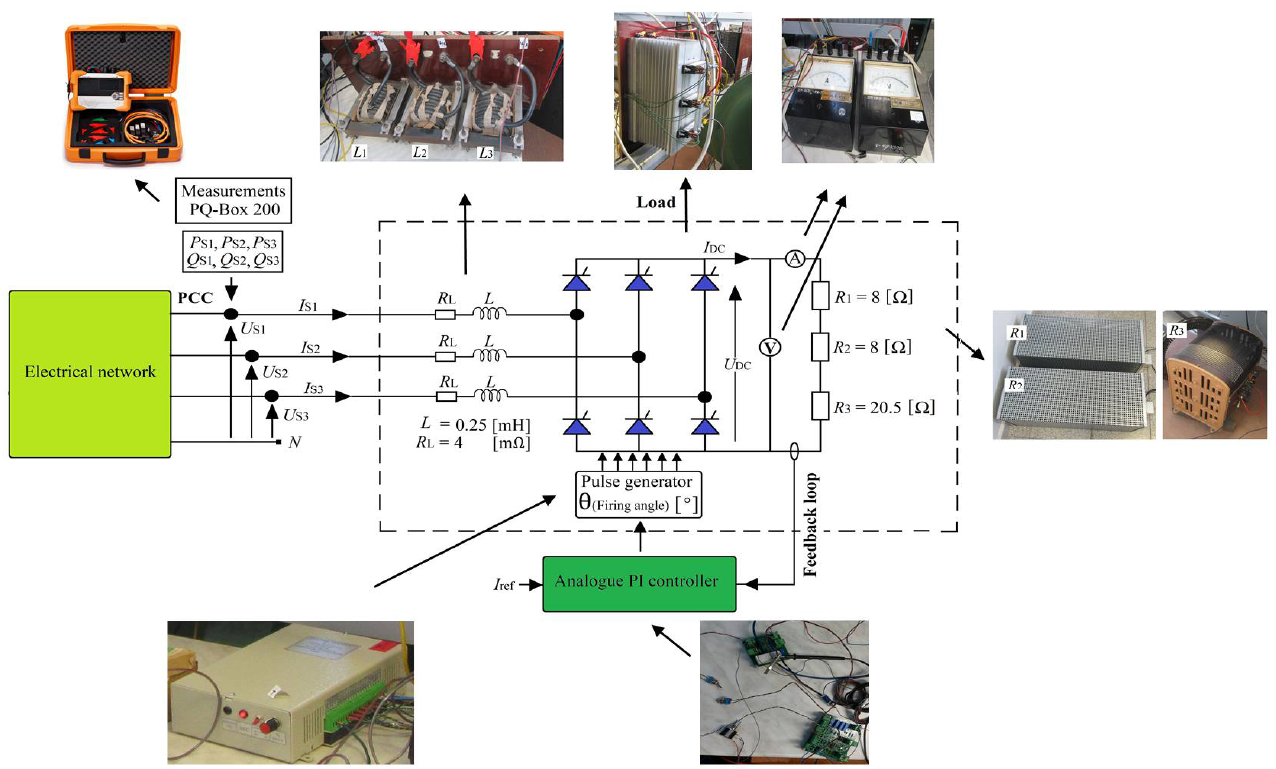
Figure 1. Block diagram representing the laboratory setup. I ref – external reference current.